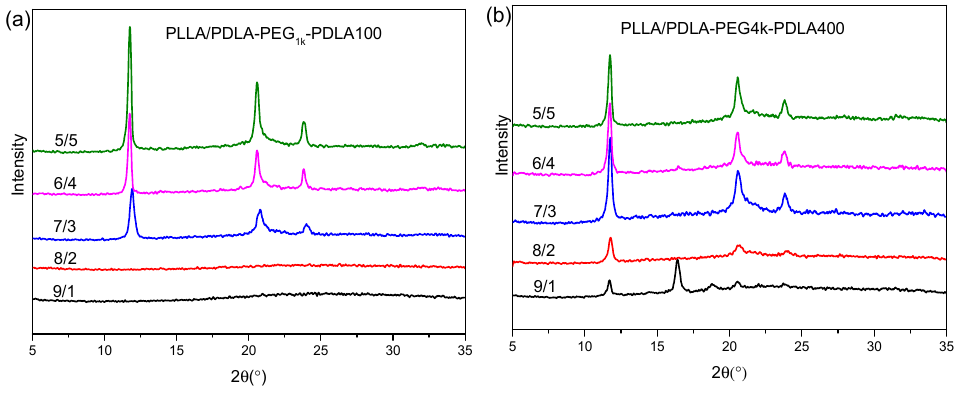
Figure 3. X-ray diffraction (XRD) curves of PLLA/PDLA-PEG 1k -PDLA100 ( a ) and PLLA/PDLA-PEG 4k -PDLA400 ( b ) with different L/D ratios (Each sample was first melted at 240 °C for 4 min and then cooled to room temperature at 10 °C/min).